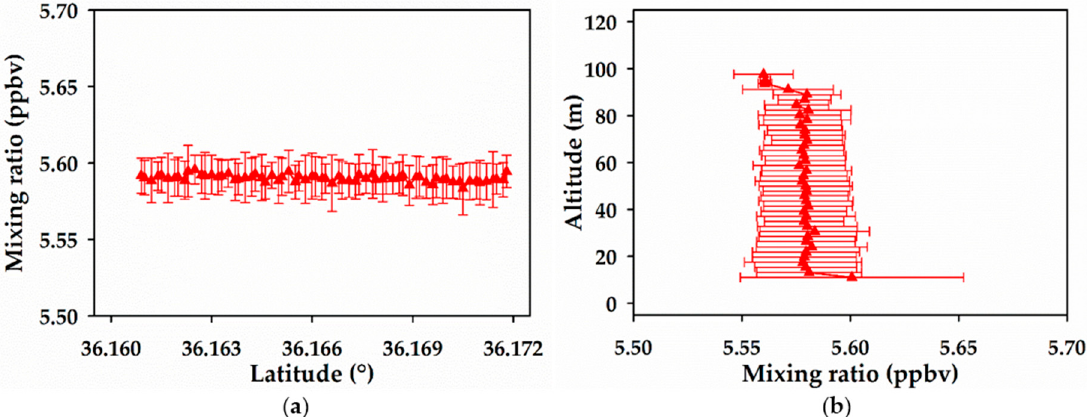
Figure 8 . ( a ) The horizontal and ( b ) the vertical flight paths measuring the variable mixing ratio of (red triangle) NH 3 during the morning of 28 June, 2017 from 6:04 to 6:56 am (UTC–5 h).